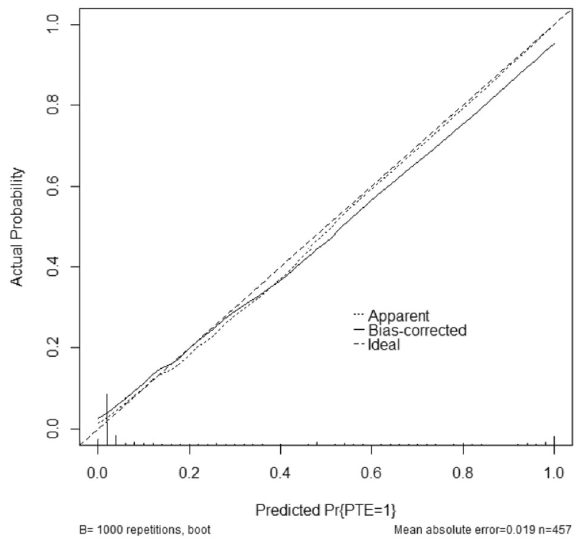
Figure 5. The calibration plot between the predicted results and the actual results. The prediction results (curve) are consistent with the theoretical results (diagonals), which means the accuracy of the prediction results.